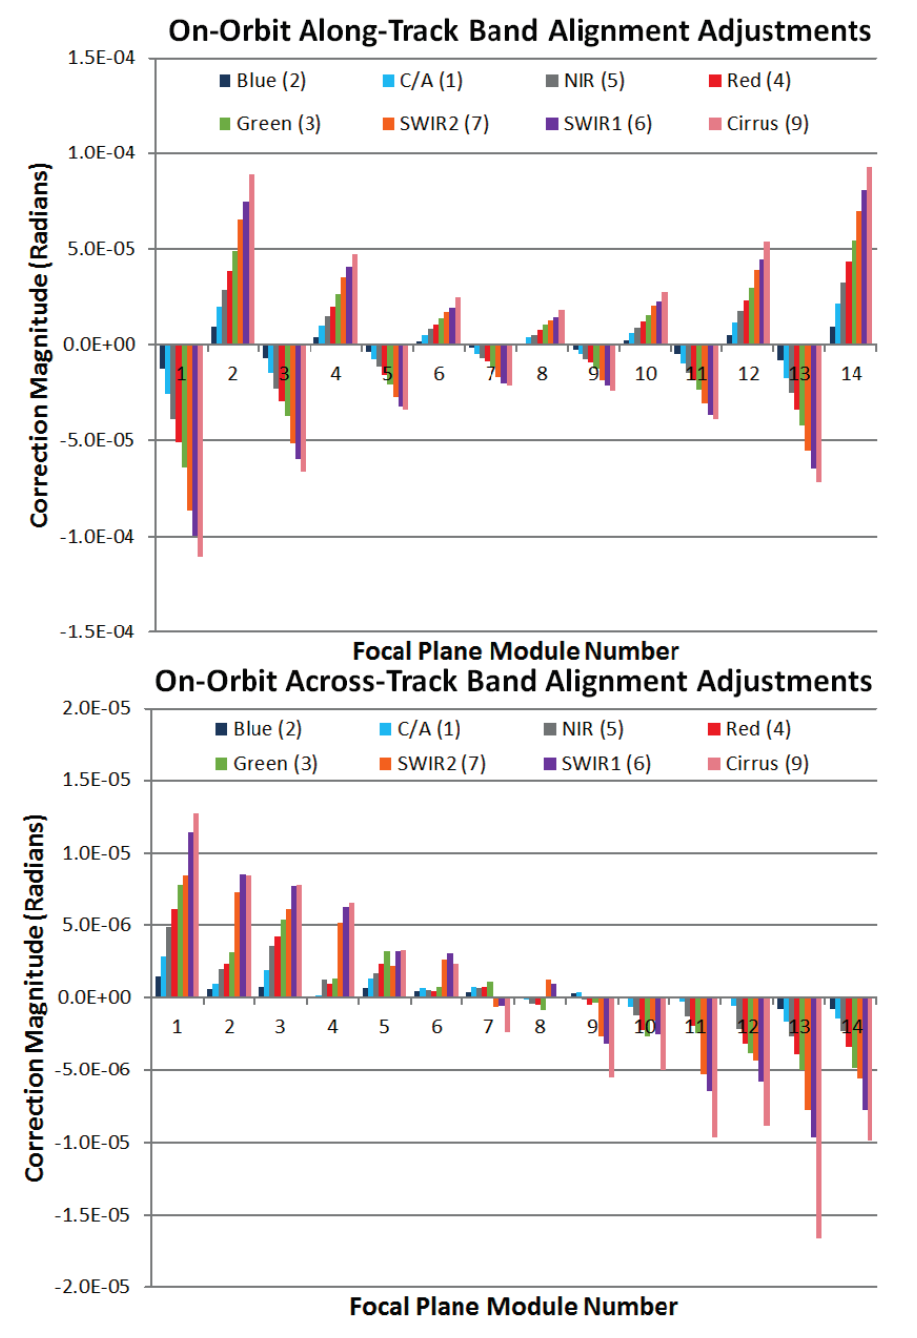
Figure 7. On-orbit band-to-band alignment corrections; top—in the along-track direction; and bottom—in the across-track direction. The bands are plotted in the focal plane